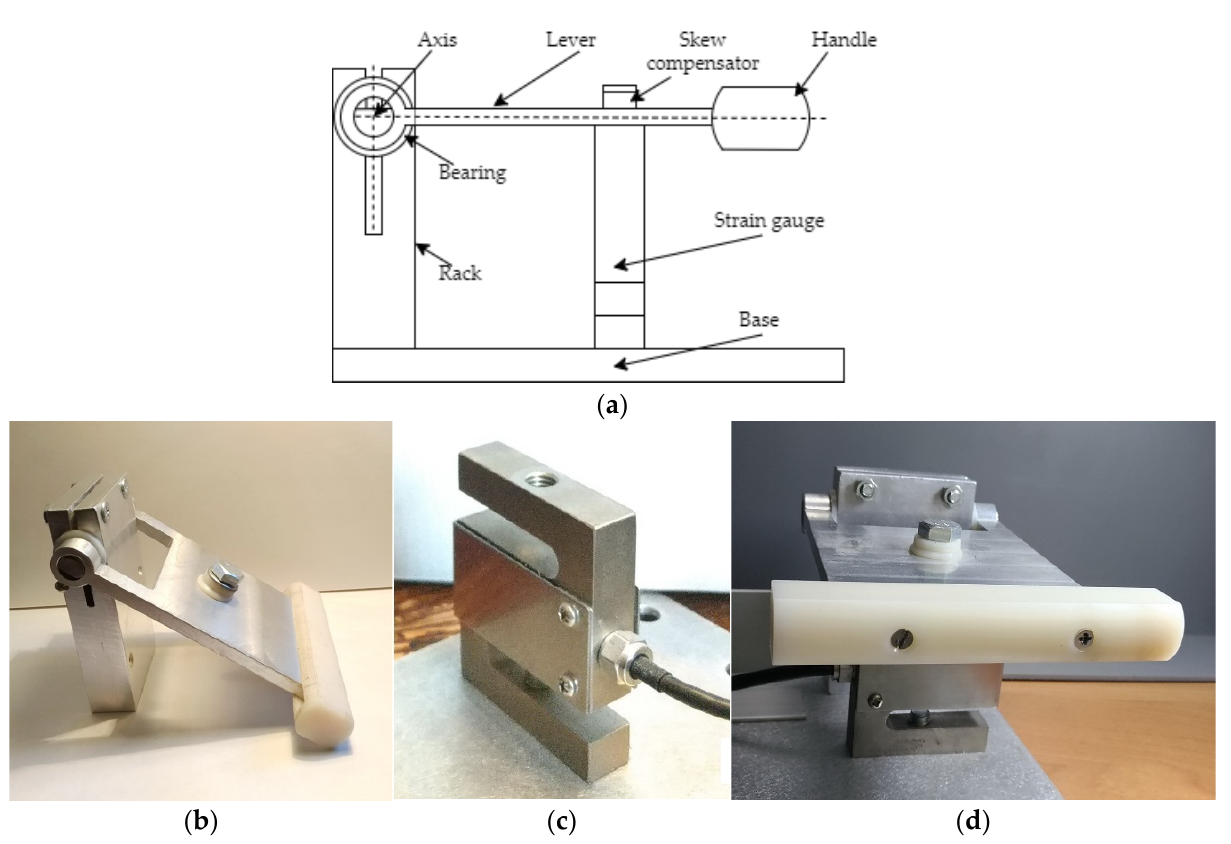
Figure 3. Force measurement unit: ( a ) schematic design, ( b ) side view, ( c ) S-shaped strain gauge, ( d ) handle side view with sensor installed.